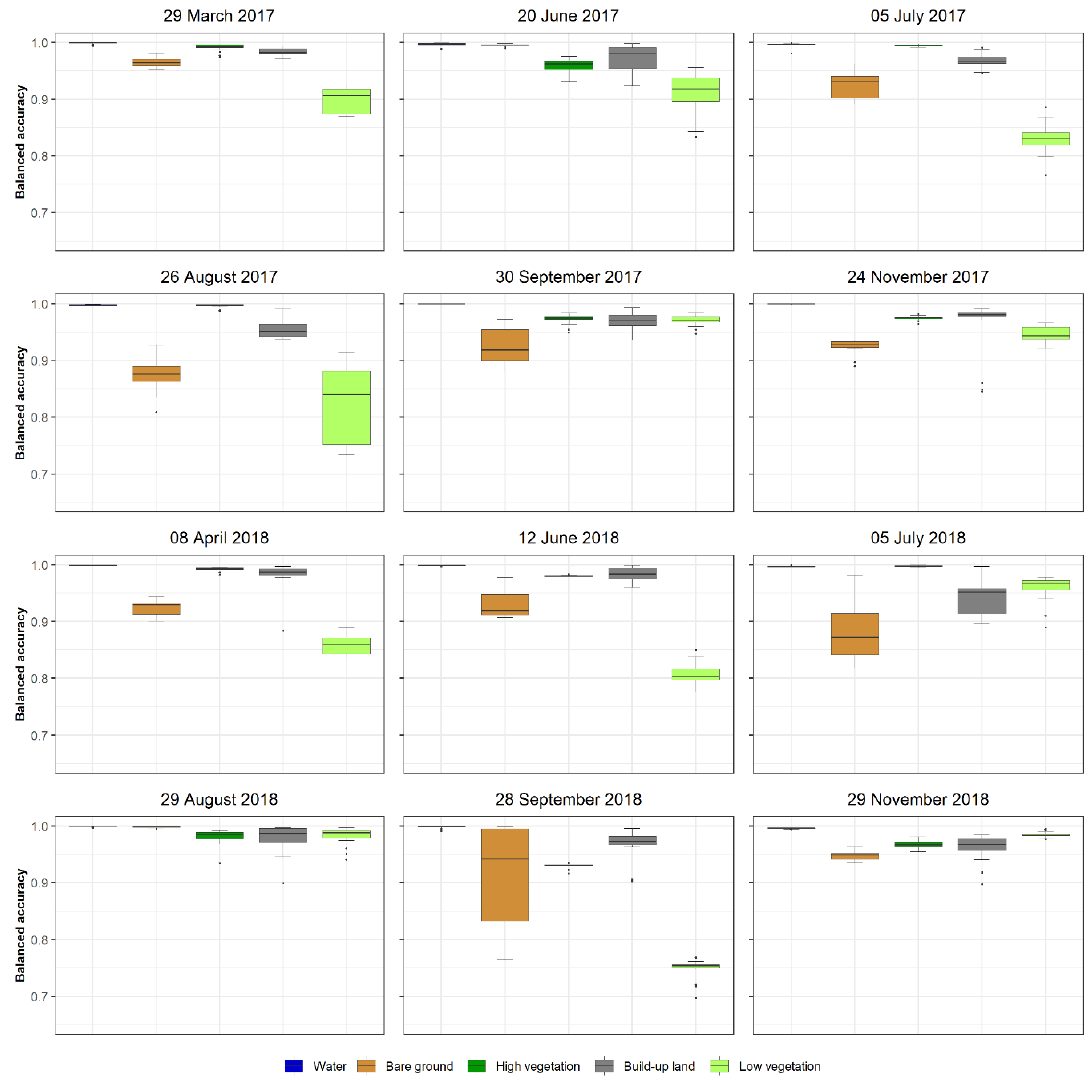
Figure 8. Box-plot of balanced classification accuracies of land cover classes with radiometric indices for combined atmospheric corrections for twelve dates.